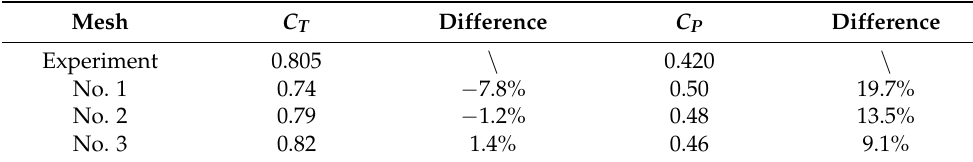
Table 5. Turbine force coefficients from [6] and from LBM-LES simulations at TSR = 3.67 and I = 3%. Differences are calculated between the experiment and